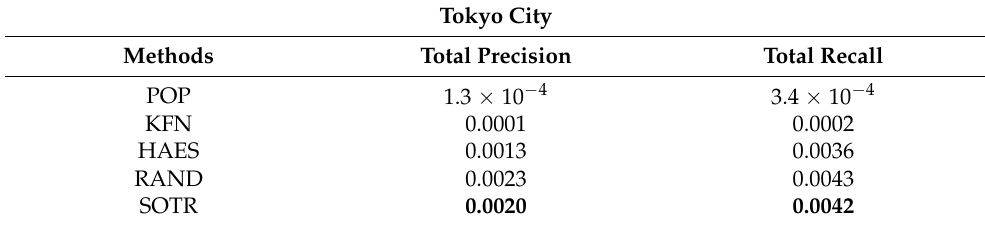
Table 7. The experimental results for Tokyo City, addressing the cold-start problem using novelty.